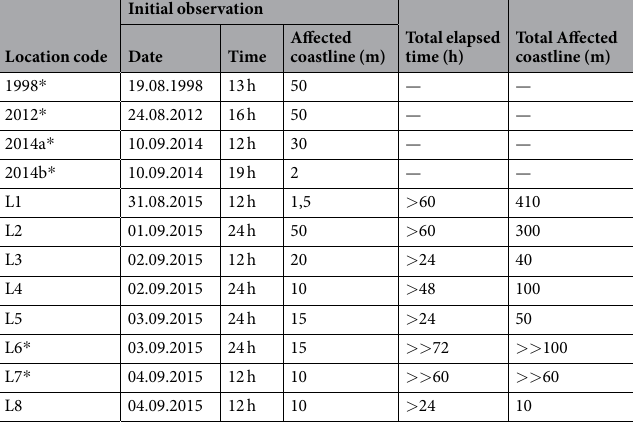
Table 1. Observed spawning events by Lithophaga lithophaga at each of the detected locations (Fig. 2). Affected coastline on the date/time when spawning was observed initially and total elapsed time and total affected coastline at each location. * Unknown time of spawning termination. > Due to the adopted field observation methodology (every 12 h) total elapsed time can be a maximum of 24 h longer than the indicated value. >> As spawning termination was not detected, total elapsed time can be significantly